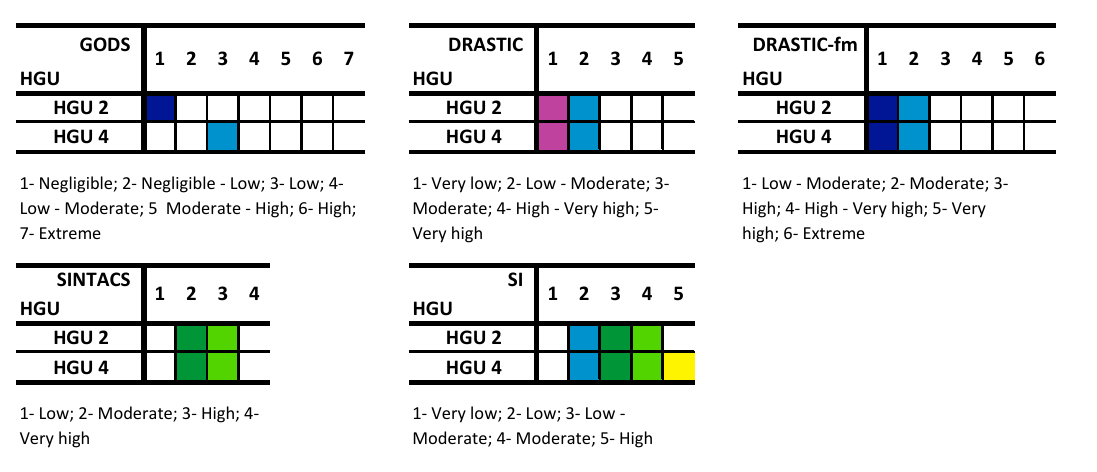
Figure 8. Matrix of hydrogeological units and each of five potential groundwater vulnerability indexes